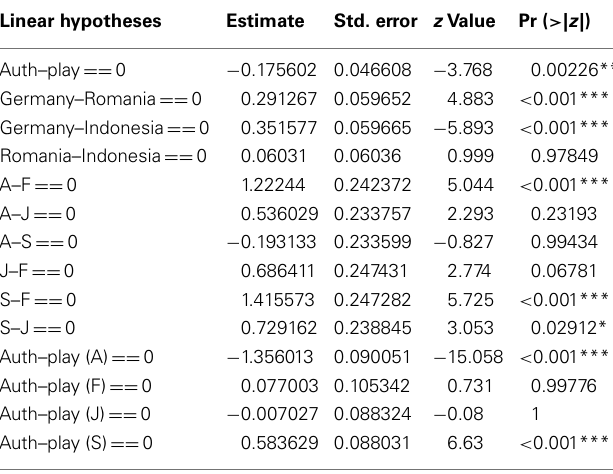
Table 1 | Post hoc tests of cultural affiliation, and stimulus-specific factors (stimulus authenticity, intended emotion) on the probability of correct emotion